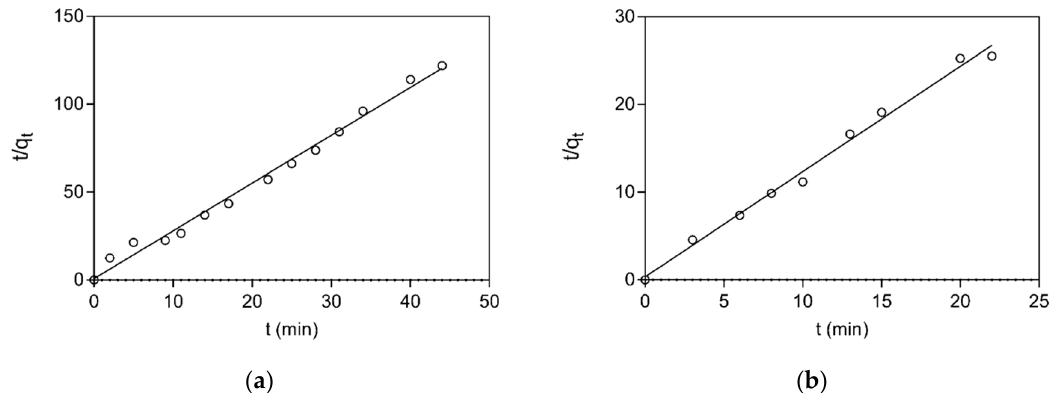
Figure 6. Pseudo-second order adsorption kinetics of BSA ( a ) and LYS ( b ) onto CB3GA-Cellulose-2 adsorbent. Table 2. Pseudo second-order adsorption rate constants for the adsorption of LYS and BSA on CB3GA-Cellulose-2 affinity adsorbent.